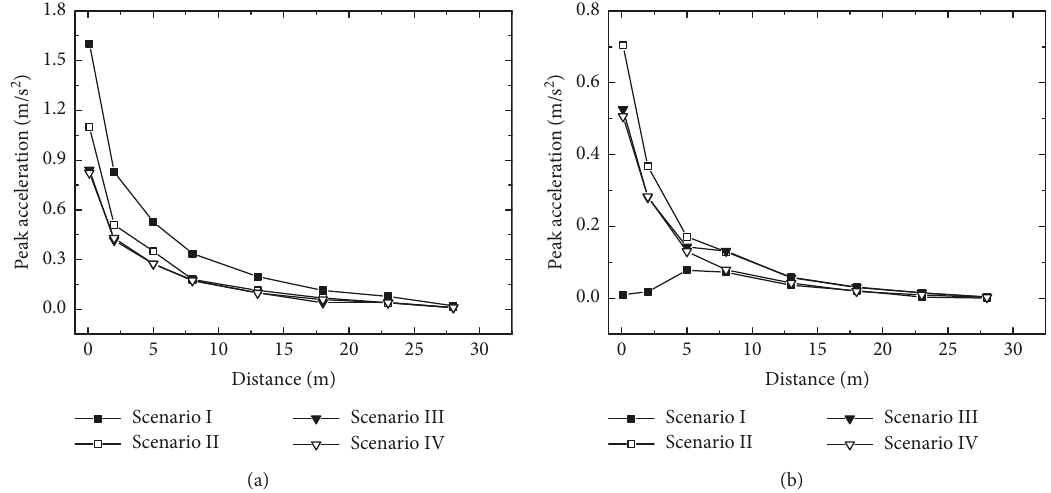
Figure 13: Trend of the acceleration variation. (a) Vertical acceleration. (b) Horizontal acceleration.